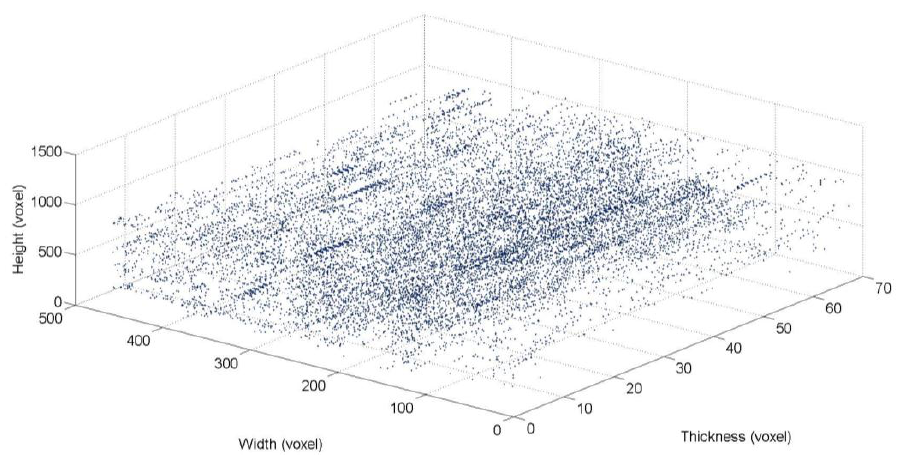
Figure 4. Seed voxels of a typical 50 mm anode slice containing cracks and pores (10 voxels ≈ 7 mm).